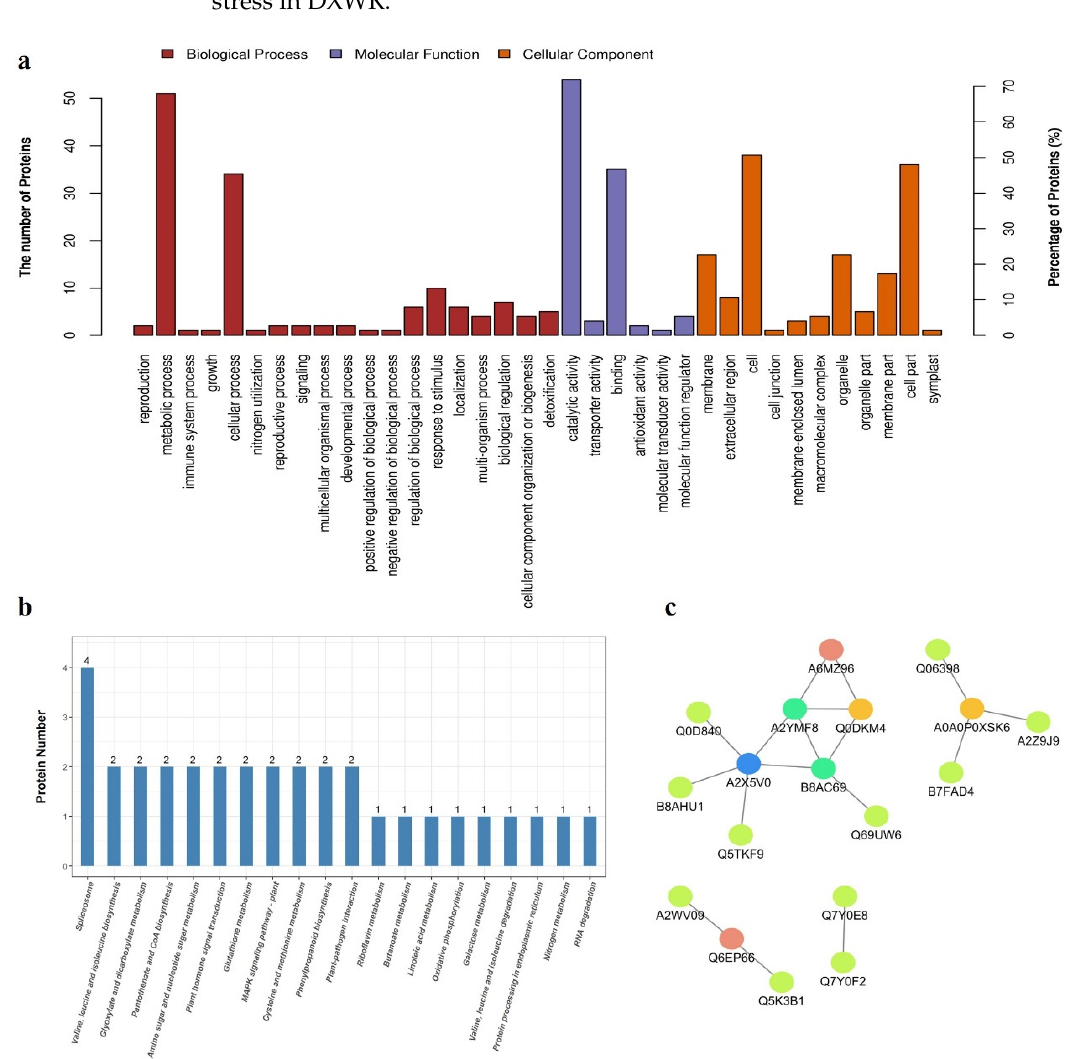
Figure 2. Analysis of identified proteins signi fi cantly different between the RCK and RLP samples. ( a ) Gene Ontology (GO) annotation of the proteins signi fi cantly different between the RCK and RLP samples. ( b ) The top 20 KEGG pathway assignments of the proteins signi fi cantly different between the RCK and RLP. The represented categories ( Q ≤ 0.05) and the number of proteins predicted to belong to each category are shown. ( c ) The protein-protein interactions (PPI) between the identified proteins. The sphere represents the protein, and the straight line represents the interaction between the proteins at both ends of the straight line.